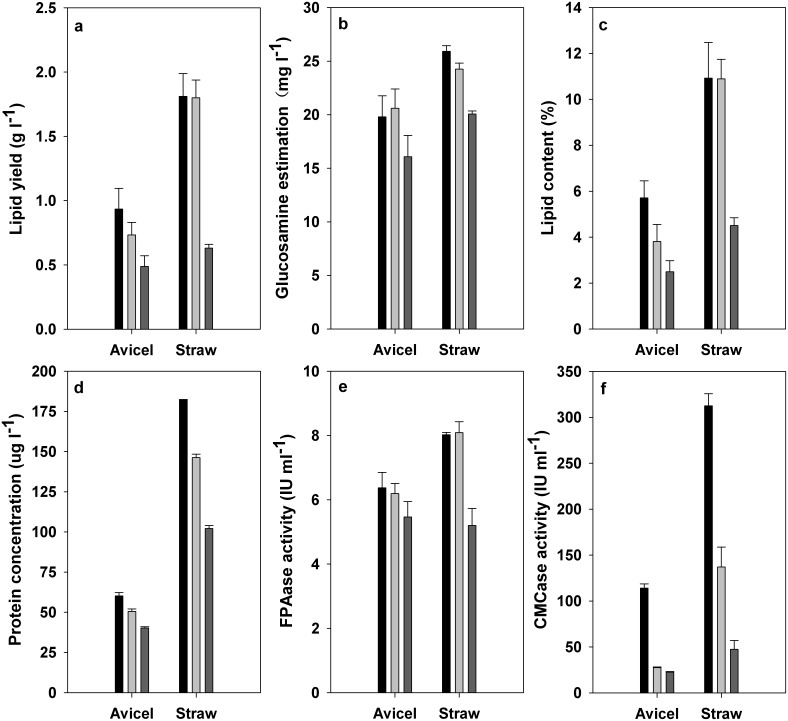
The lipid production (A, C), cell growth (B), cellulase secretion (E, F) and extracellular protein secretion (D) of A2-2 (black column), D1-B1 (gray column) and wild-type A-4 (dark gray column) in SmF experiments using avicel and straw based media, respectively.